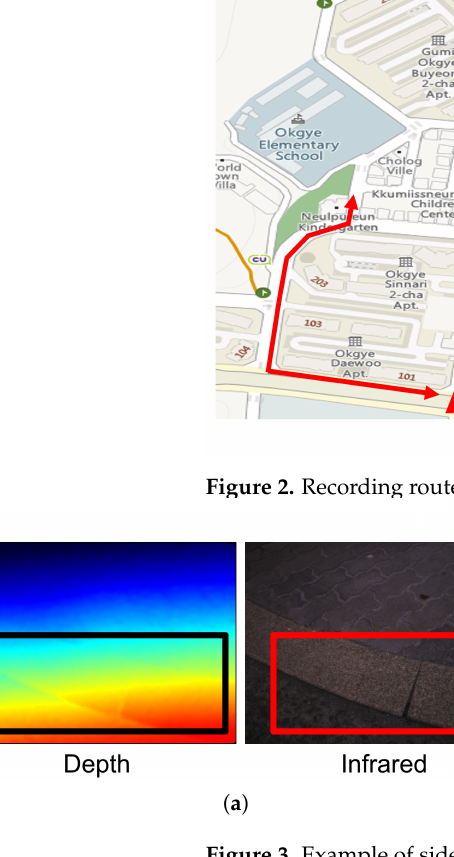
Figure 3. Example of sidewalk images. ( a ) Damaged sidewalk, ( b ) Normal